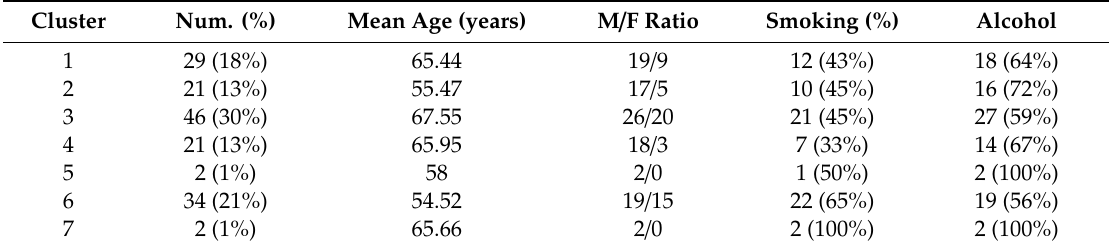
Table 3. Clusters analysis: The demographic data within each cluster.